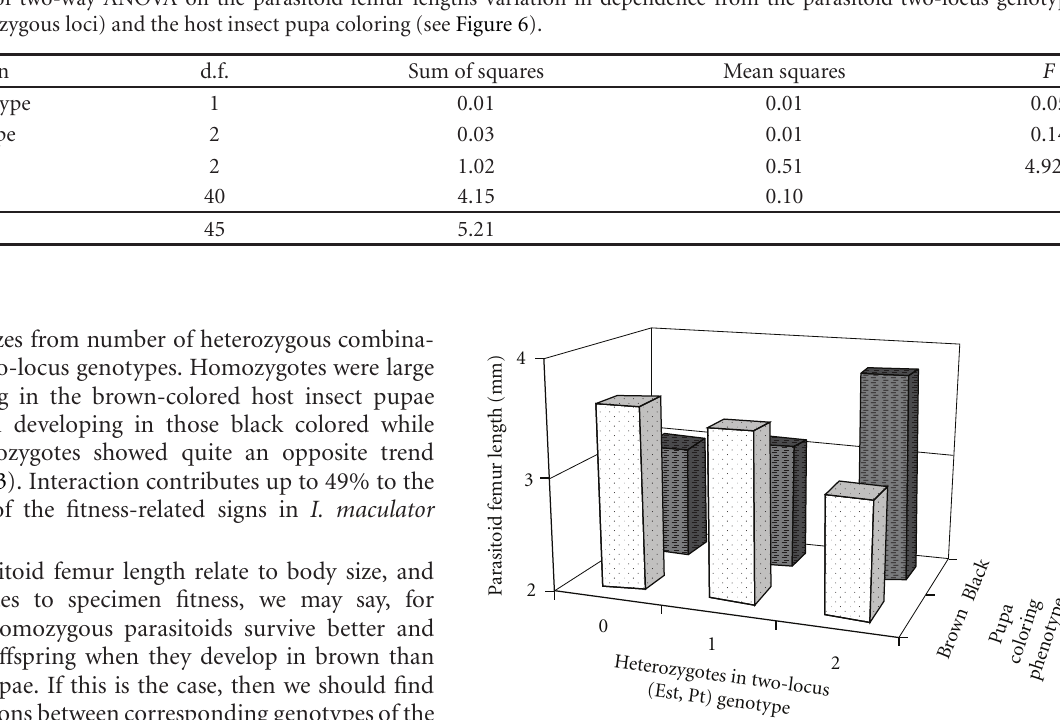
Figure 6: Femur lengths in the I. maculator males in dependence on their two-locus (Est, Pt) genotype (number of heterozygous loci) and phenotypes of their host insect pupae (results of two-way ANOVA in Table